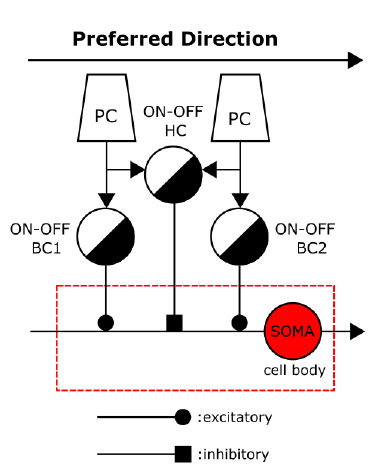
Figure 4. The structure of local motion direction detection neurons.